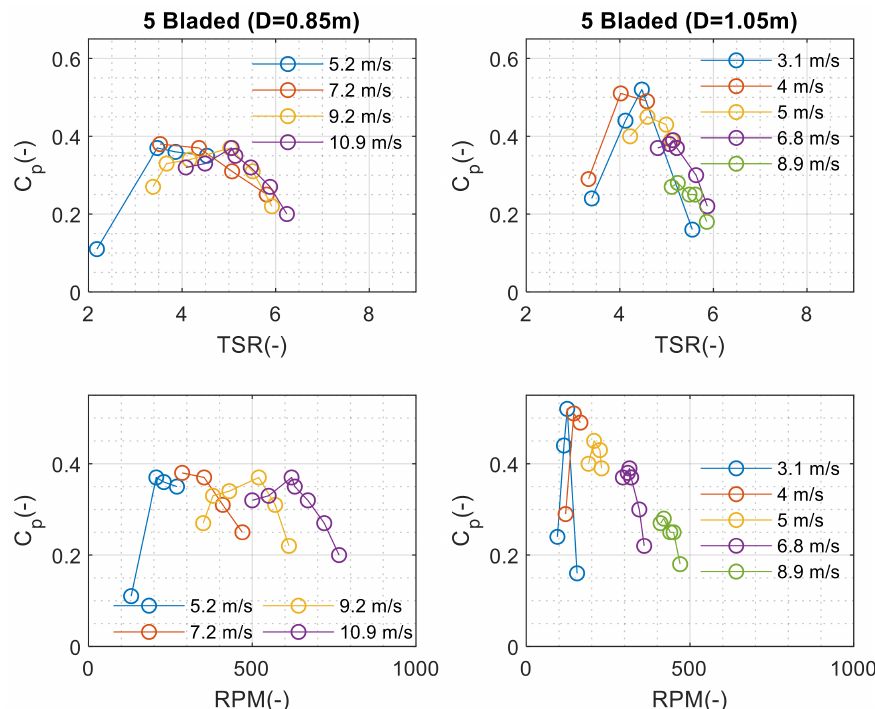
Figure 18. Wind tunnel results of generator’s C p - λ (top) and C p -RPM (down) curves of different rotor diameter 5 bladed upwind rotor configurations ( left graphs for 0.85 m diameter and right graphs for 1.05 m diameter) based on P gen (W) power after the generator for different wind speeds (see